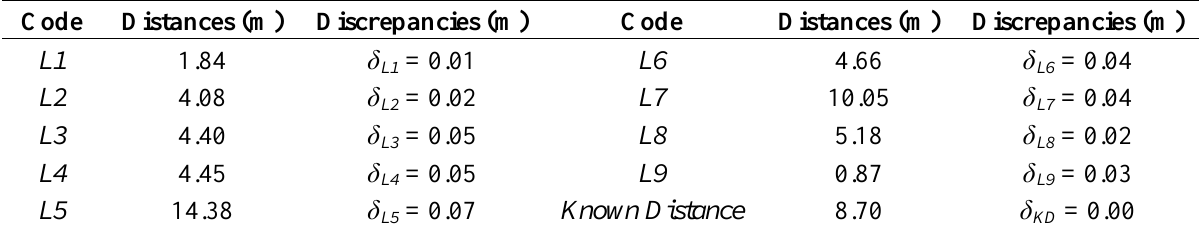
Table 4. Accuracy assessment: dimensional analysis of